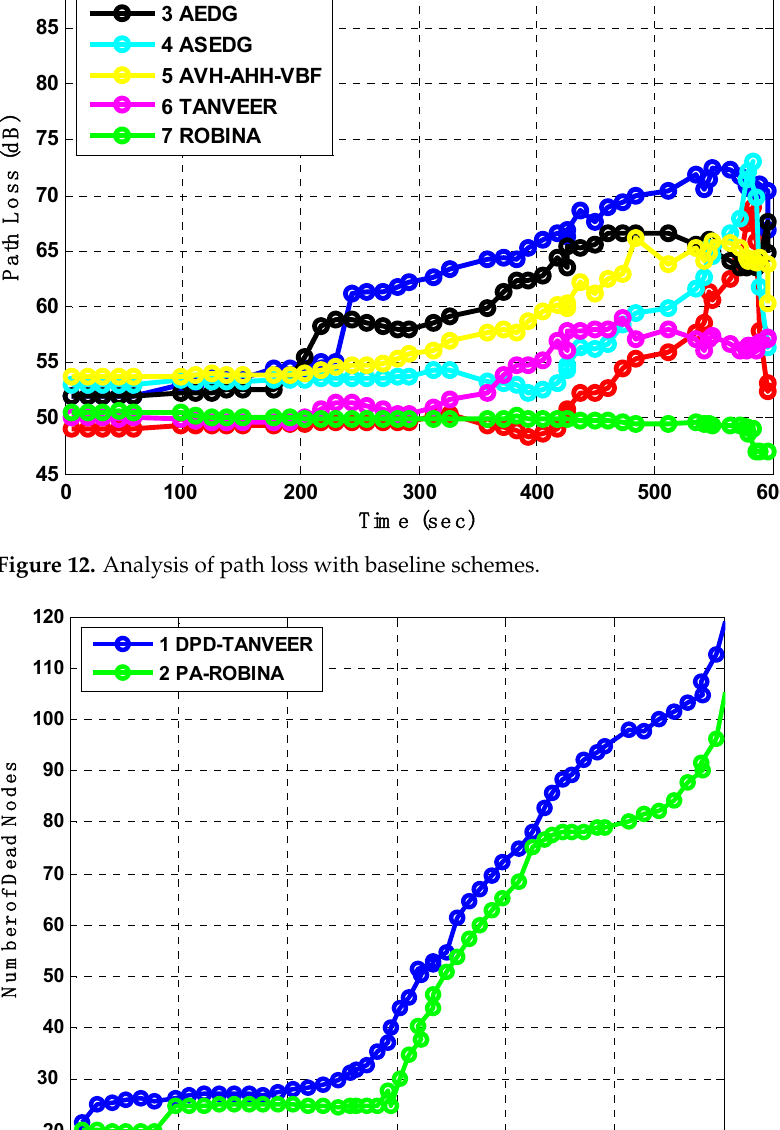
Figure 14. Analysis of the number of dead nodes compared with DPD-TANVEER and PA-ROBINA. 7.7. Analysis of DPD-TANVEER and PA-ROBINA with Energy Tax The amount of EC was experimented with and shown in Figure 15 between RO- BINA with its other selected similar state-of-the-art schemes. Energy is the fundamental parameter in all routing protocols, even where the unmanned efforts requiring the re- placements of nodes or batteries are much more difficult. Due to the atomic path with its MNs used in AEDG and ASEDG, EC is higher than WDFAD-DBR and EBER 2 , which we did not consider in experiments because ROBINA used the capacity of internodes ad- justment and had a mechanism to avoid void holes. Hence, it saved the most energy among all routing schemes when it was used.